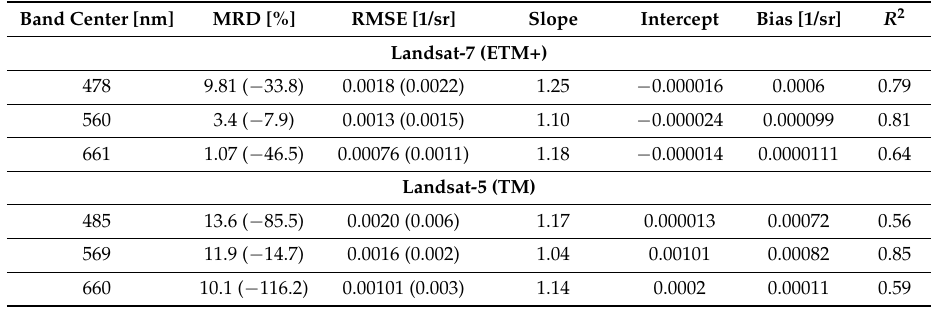
Table 4. The statistics associated with matchup analyses of Landsat-7 and -5 at AERONET-OC sites. The values in round brackets refer to statistics derived prior to implementing the gains listed in Table 3. The large RMSEs and deviations of slopes from unity are associated with random and systematic errors in TM and ETM+ observations. The Landsat-5 matchups are available only for the last eight years of the mission.